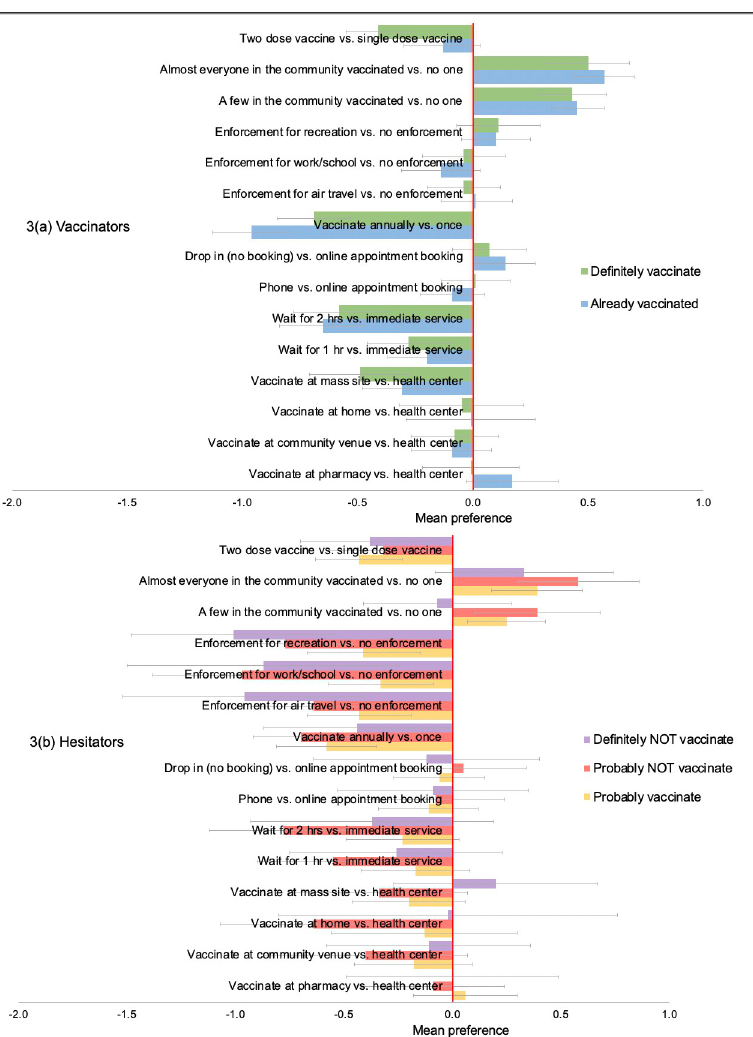
Fig 3. Weighted mean preferences (relative utilities) for vaccination campaign features, among (a) vaccinators and (b)